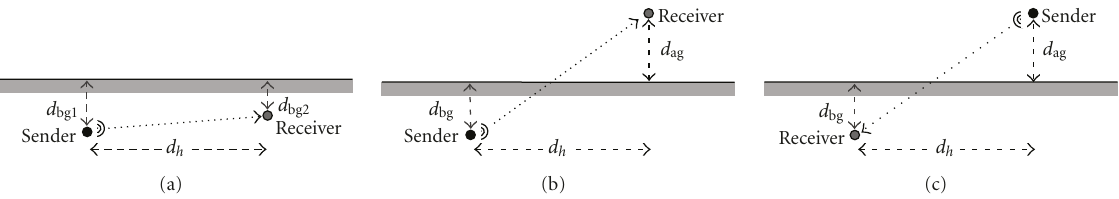
Figure 1: The three communication scenarios supported by the WUSN testbed: (a) underground-to-underground (UG2UG), (b) underground-to-aboveground (UG2AG), and (c) aboveground-to-underground (AG2UG) communication.